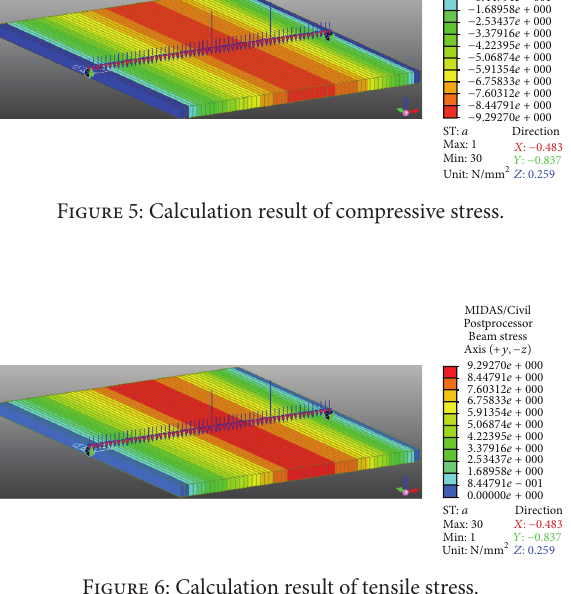
Figure 6: Calculation result of tensile stress.